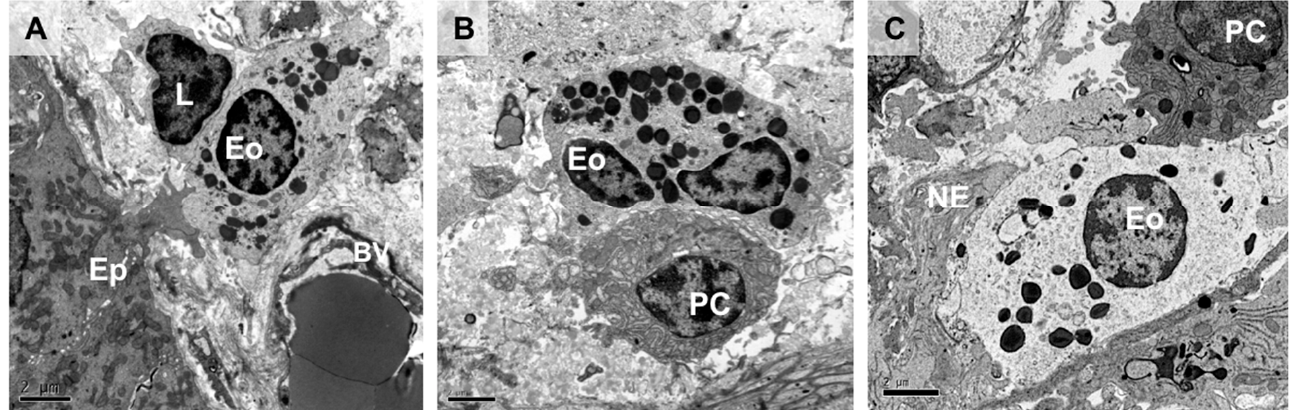
Figure 1. Intestinal eosinophils in close proximity to mucosal resident cells. Transmission electron micrographs of healthy human intestinal mucosa showing interactions of eosinophils with epithelial cells, nerve endings, and other immune cells. The eosinophil is identified based on morphological characteristics, mainly the cytoplasmic granules with well-defined electron-dense cores (crystalline cores) and a bilobed nucleus (not always observable under transmission electron microscopy). ( A ) Intestinal epithelial cell extending a protrusion to establish direct contact with a subepithelial eosinophil which is in contact with a lymphocyte. ( B ) Eosinophil physically interacts with a plasma cell in the intestinal mucosa, along the surface of the cell membrane. ( C ) Dual interaction of an eosinophil with a plasma cell and a free nerve ending along its cell membrane. Ep, epithelium; L, lymphocyte; Eo, eosinophil; BV, blood vessel; PC, plasma cell; NE, nerve ending. Bar: 2 µm.